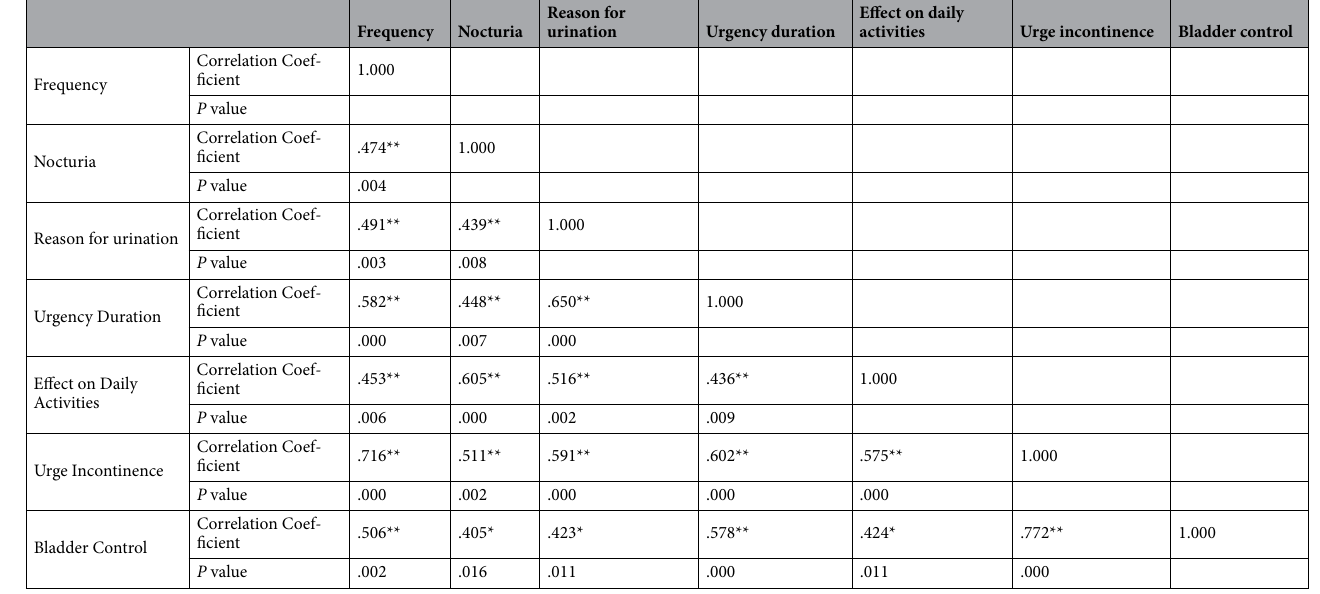
Table 3. Pearson correlation between overactive bladder symptoms. **Correlation is significant at the 0.05 level